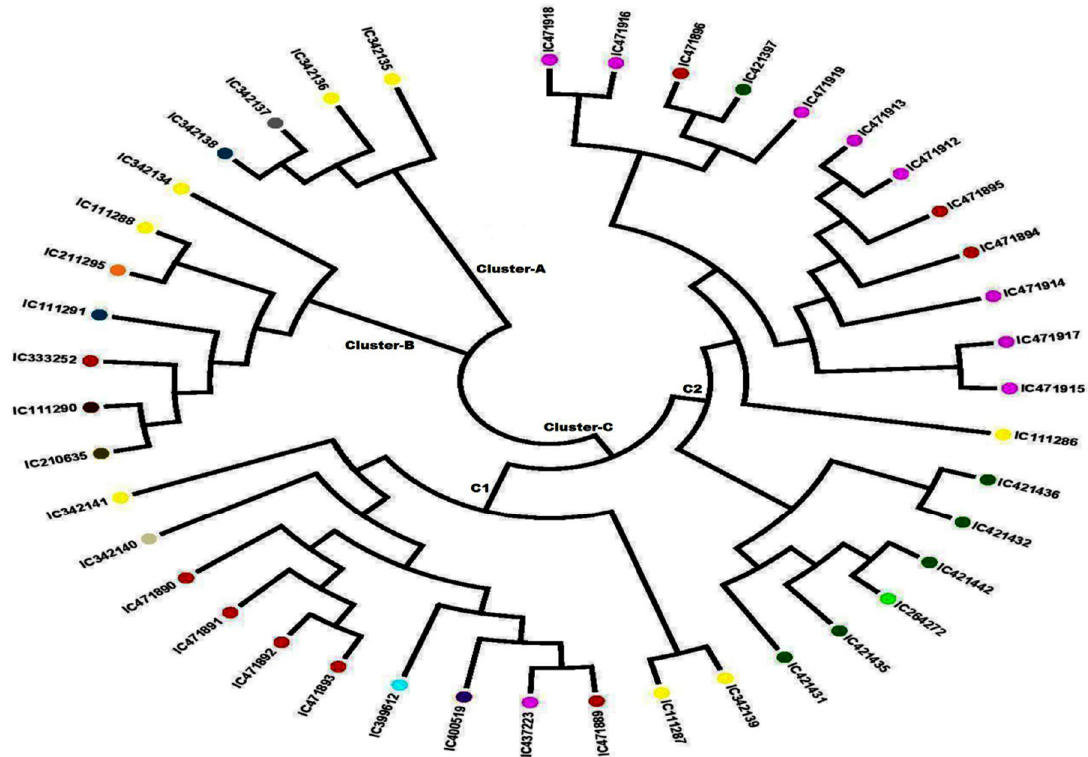
Figure 3. Neighbor-joining (N-J) phylogenetic tree showing the grouping of 42 accessions of Andrographis paniculata based on the data of 41 SSR